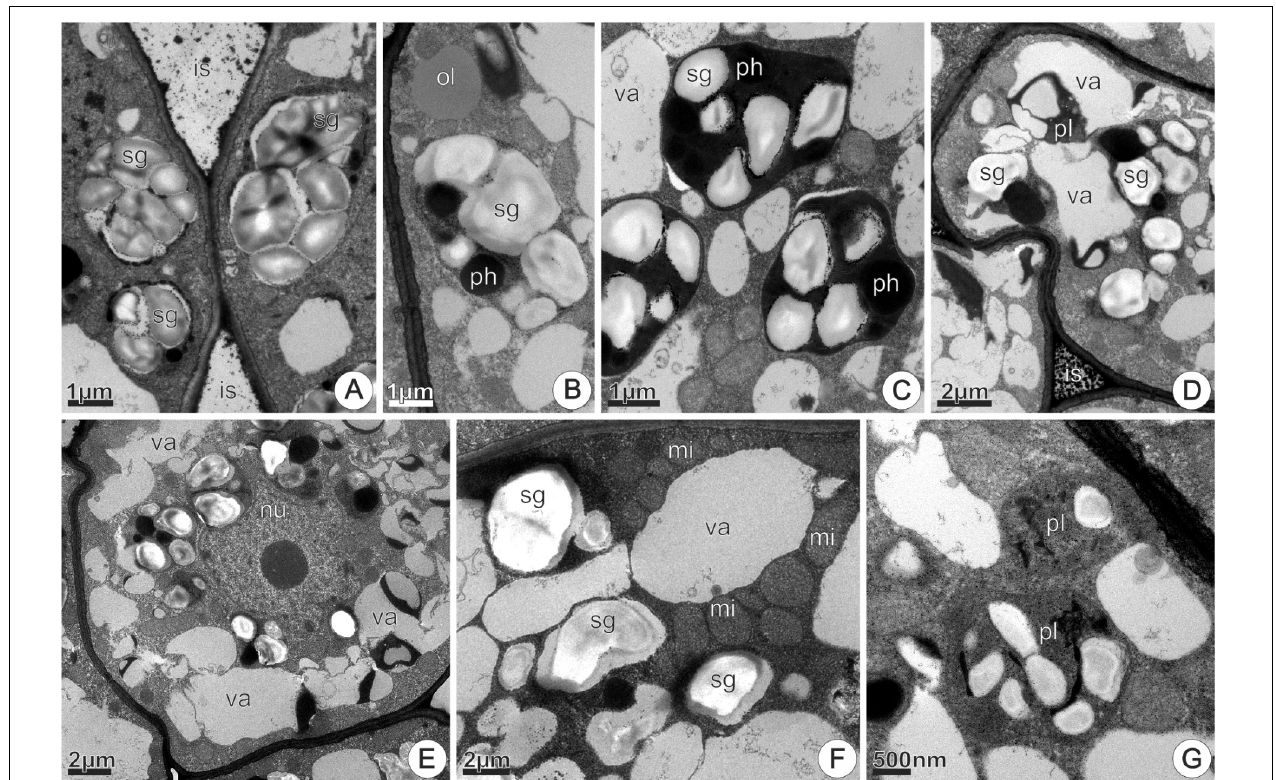
FIGURE 12 | TEM micrographs of the disk from Jacaranda oxyphylla nectarless flowers, at 48 h of anthesis, highlighting the plastids change in the deeper parenchyma layers. (A) Bigger amyloplasts in the periphery of the cell and black granulations adhered in the cell walls bounding the intercellular space; (B) amyloplast with voluminous starch grains and phenolic inclusions. Note oil drop in the cytosol; (C) denser amyloplasts with signs of starch hydrolysis; (D) degenerating amyloplast engulfed in the vacuole; (E) merged vacuoles from amyloplasts degeneration in the periphery of the cell, and amyloplasts clustered around the nucleus; (F) mitochondria assembled around vacuoles; (G) Chloro-amyloplasts with undeveloped thylakoids. is, intercellular space; mi, mitochondria; nu, nucleus; ol, oil; pl, plastid; ph, phenolic content; sg, starch grains; va,